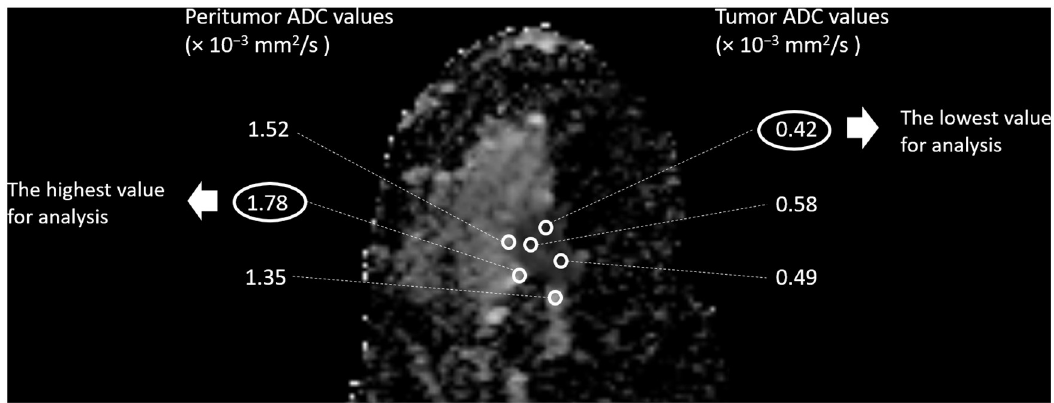
Fig 2. Methods used to measure the tumor and peritumor apparent diffusion coefficient (ADC) values. The ADC map on the slice with the largest tumor cross-sectional area was selected for measurement, and three round regions of interest (ROIs) were placed inside the tumor where the ADC values appeared (visually) to be most strongly reduced. Then, three round ROIs were placed on the peritumoral breast parenchymal tissue adjacent to the tumor border at locations at which the ADC values appeared (visually) to be most strongly increased. The lowest of the three mean tumor ADC values (0.43 × 10 − 3 mm 2 /s) and the highest of the three mean peritumor ADC values (1.78 × 10 − 3 mm 2 /s) were selected for further analysis and for the calculation of the